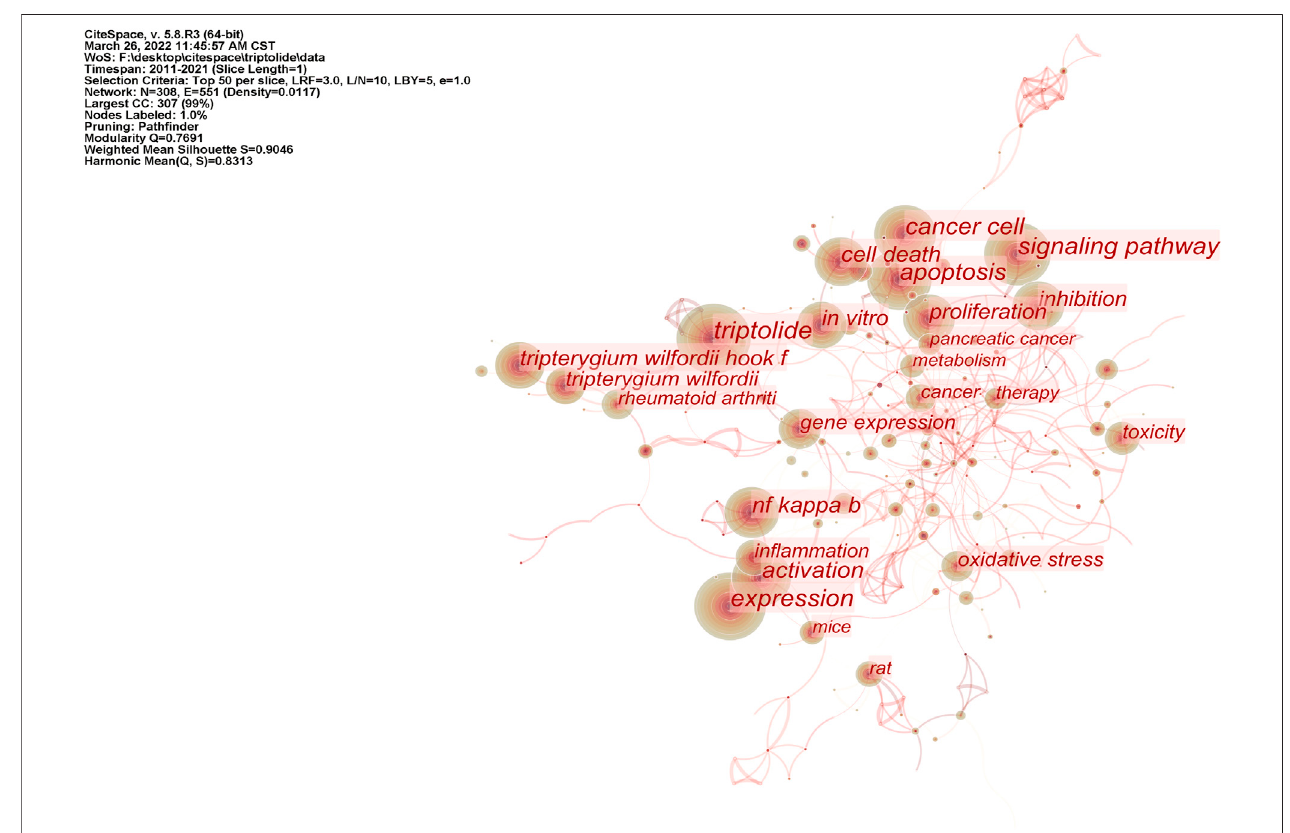
FIGURE 5 | Co-occurrence network of triptolide literature keywords from the